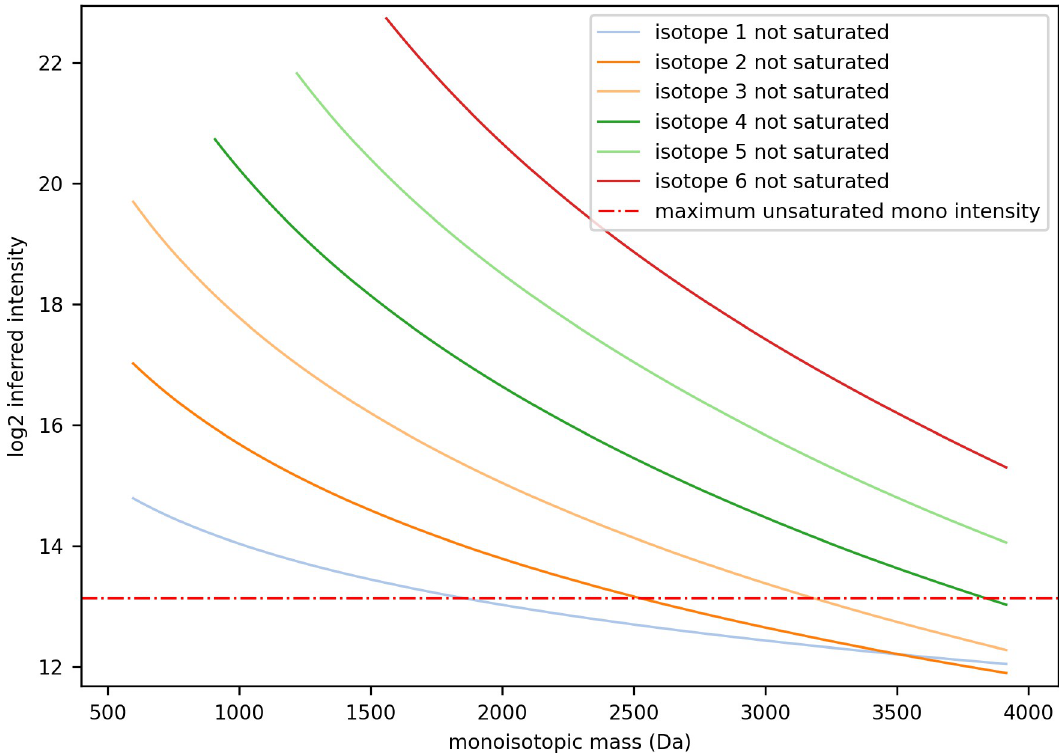
Fig 9. The maximum inferred intensity of the monoisotopic peak depending on which isotope is used to infer its intensity.